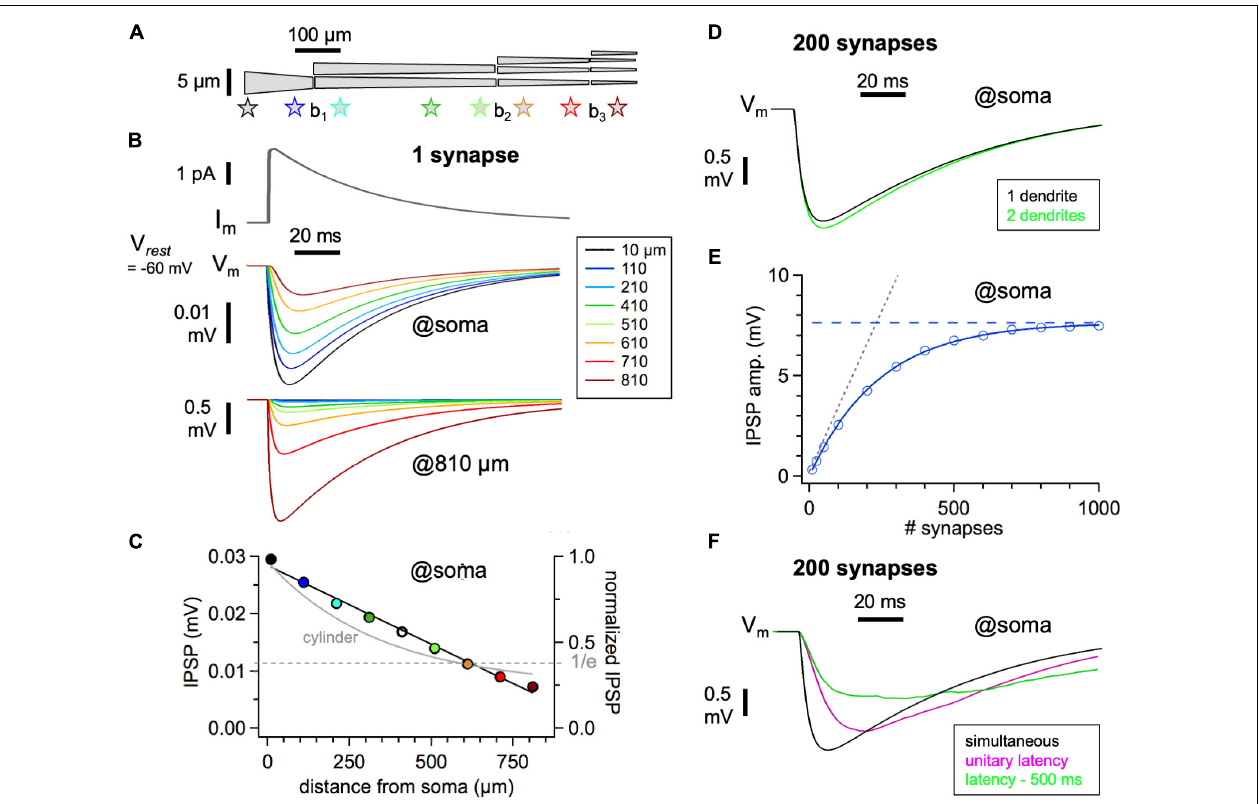
FIGURE 2 | Simulation of granule cell-mediated recurrent inhibition. (A) Model anatomy of one mitral cell lateral dendrite. Branchpoints at b 1 = 150 µ m, b 2 = 550 µ m, b 3 = 750 µ m. Total length 850 µ m, the total number of branchpoints 3. Tapering: first segment 4–2.5 µ m, second segment 2.5–2 µ m, third segment 2–1 µ m, fourth segment 1–0.5 µ m. (B) Top: Simulation of IPSC recorded at the soma under physiological conditions (10 µ m from soma, g syn = 200 pS, V m = − 60 mV, E Cl = − 80 mV). Middle: Simulation of IPSP generated at the same location and at various distances, as recorded at the soma. Bottom: IPSP at the same locations as in panel C but recorded at the distal site (810 µ m). (C) Cumulative somatopetal attenuation along the dendrite, absolute (left axis) and normalized to the extrapolated amplitude at 0 µ m (normalized IPSP, right axis). Gray line: Simulation in a cylindrical neurite without tapering. (D) Somatic recurrent inhibition exerted by 200 synapses distributed equally across 1 lateral dendrite of the mitral cell model (black trace) and with the proximal 80% of synapses shifted to another lateral dendrite (green trace). The difference between the traces indicates the reduced shunting of the distal 20% of synapses in the second case. (E) Recurrent summated IPSP amplitude at the soma versus a number of (equidistant) synapses on one dendrite. Dotted line: linear summation of unitary IPSP. Dashed line: saturation due to shunting and reduction in driving force. (F) Black trace: same simulation as in panel (D) . Magenta trace: same, but with onset latencies distributed according to Figure 1D . Green trace: the temporal extent of latency values further expanded, to 500